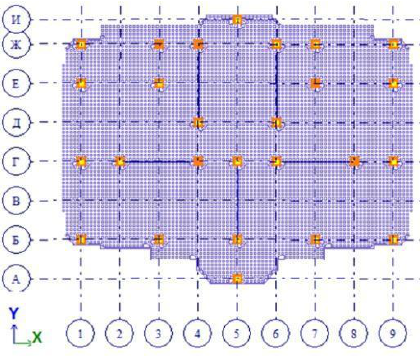
Fig. 1. Horizontal projection of the design scheme of the